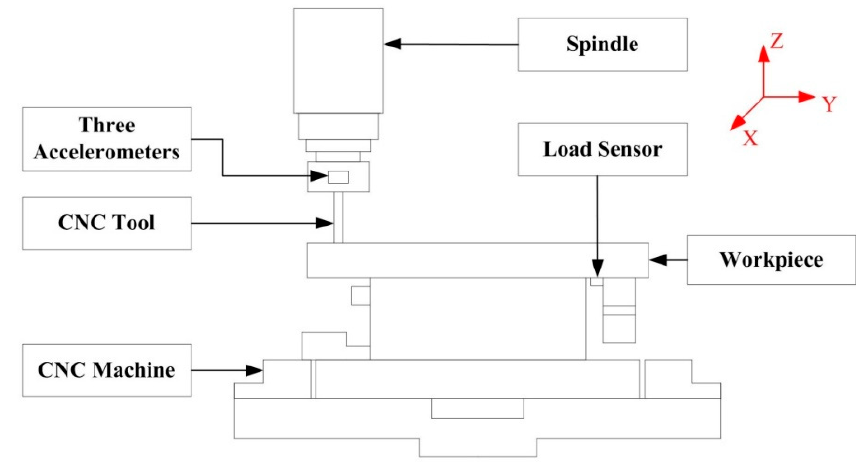
Figure 6. The main components and sensor positions of the Computer numerical control (CNC).